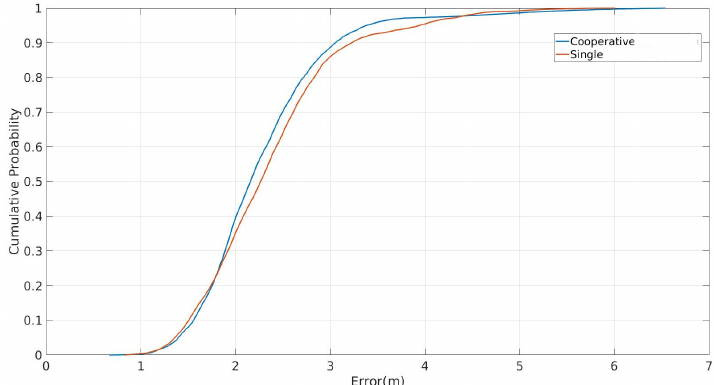
Figure 30. A CDF plot showing a comparison of the localization solution of the UAV in a cooperative network versus when operating alone.